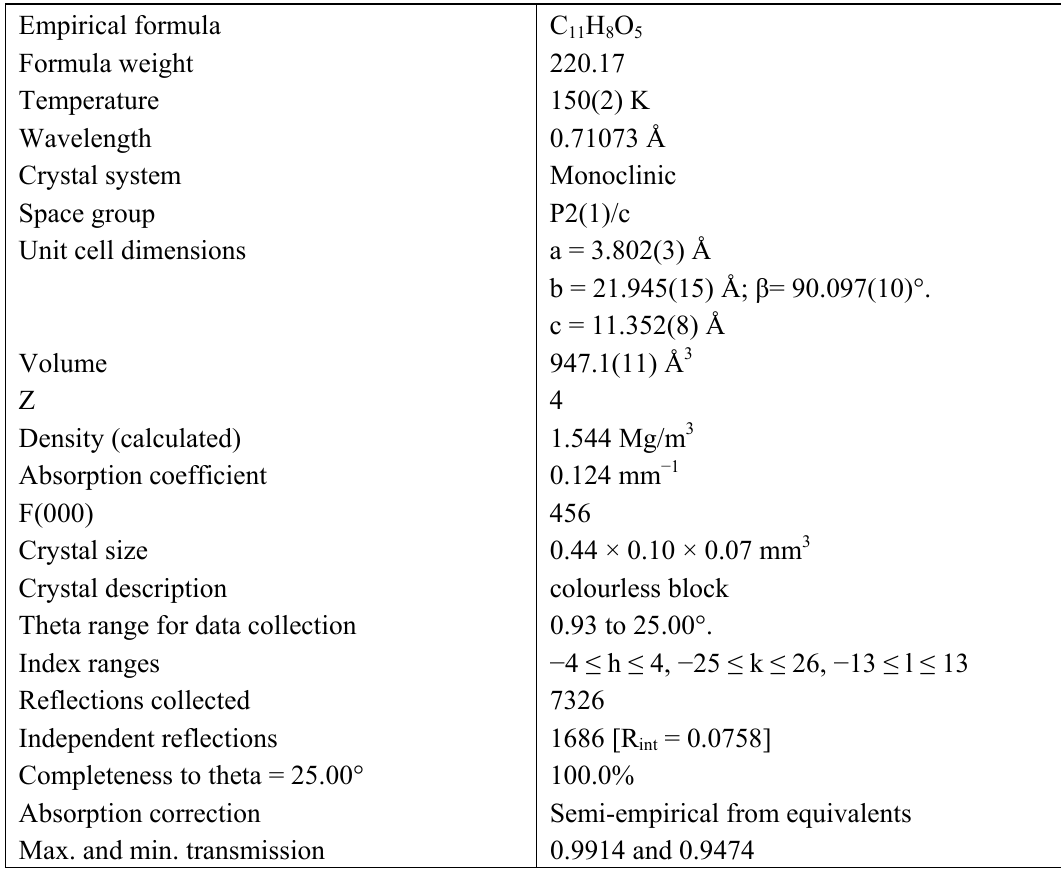
Table 1. Crystal data and structure refinement for 4-hydroxy-3-methoxycarbonyl